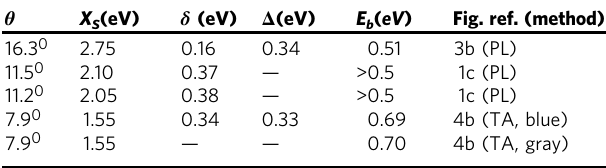
Table 1 Exciton fi ne-structure resonances